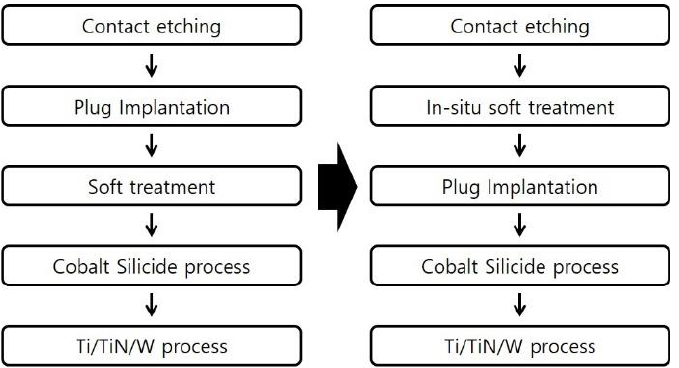
Figure 1. Experimental sequences of the conventional (left) and modified (right) processes. C 4 F 6 , C 4 F 8 , CH 2 F 2 , and CHF 3 were used to remove the oxide and nitride mask